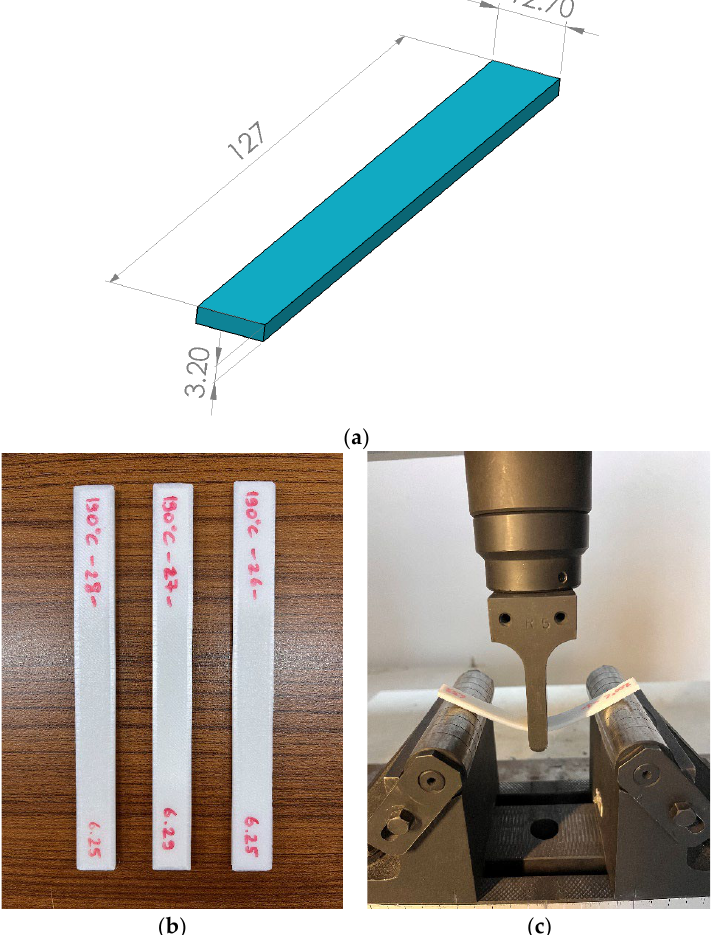
Figure 3. ( a ) CAD-model of the three-point bending test specimen according to ASTM D790 (Dimensions are given in millimetres), ( b ) produced test specimens, and ( c ) testing with Shimadzu 100 kN testing device.